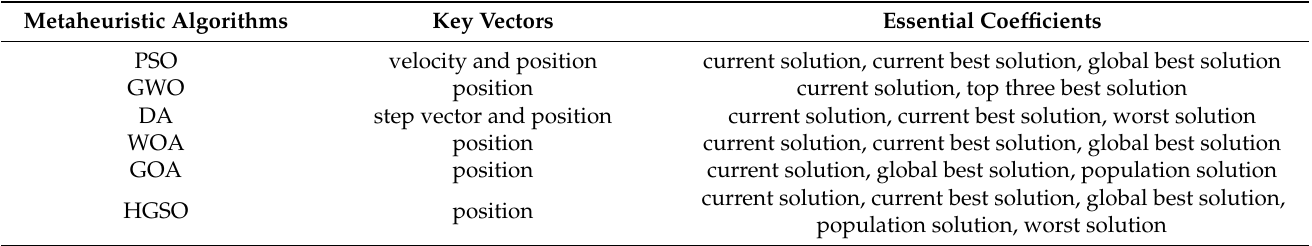
Table 1. Detailed comparative analysis concerning the key vectors and essential coefficients in the metaheuristic algorithms. Metaheuristic Algorithms